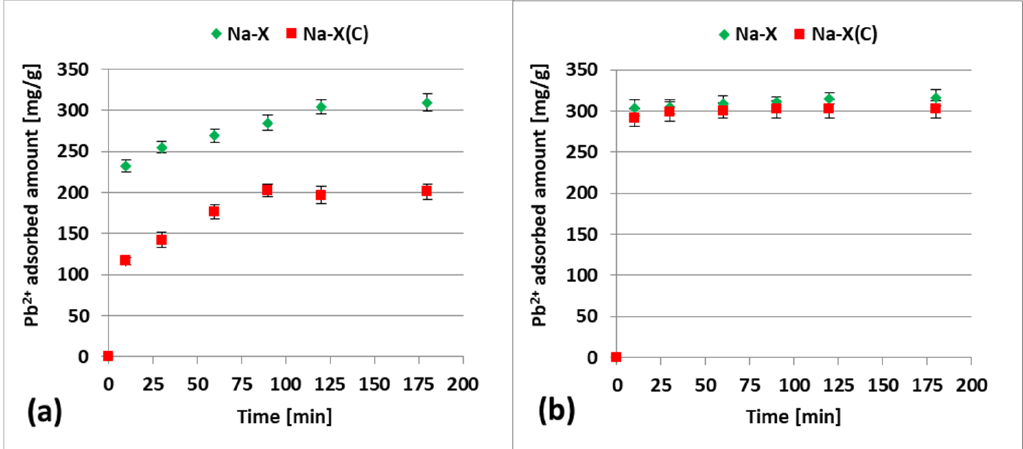
Materials 2021 , 14 , 2832 12 of 18 Figure 8. Adsorption kinetics of Pb 2+ ( a ) and Zn 2+ ( b ) on Na-X and Na-X(C) in the mixed systems, at pH 5.